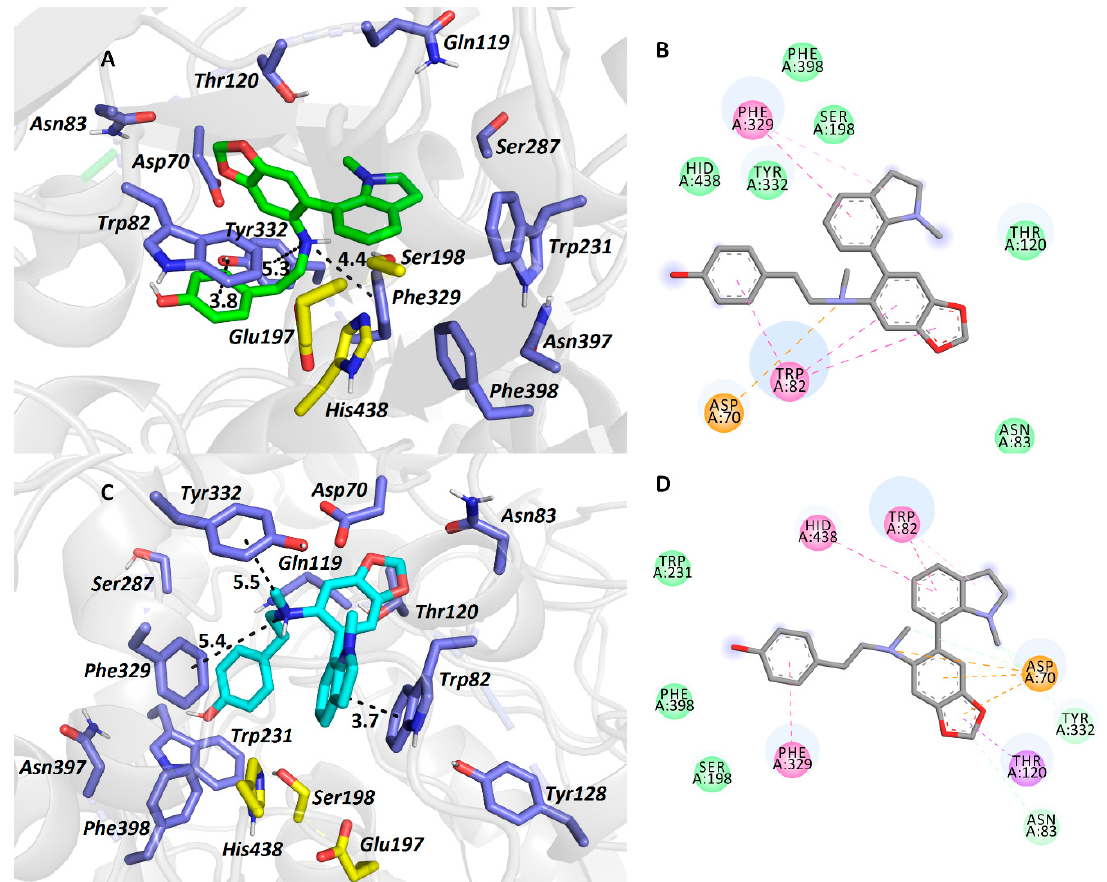
Figure 5. h BuChE active site in complex with ( R )- 14 (in green, A and B) and ( S )- 14 (in light-blue, C and D ) pseudo -enantiomers. All the amino acids exhibiting in the vicinity of the ligands up-to 6.0 Å are rendered. Hydrogen atoms of amino acids are omitted for clarity. Catalytic triad residues are shown in yellow and amino acid residues in blue ( A and C ). In 2D diagrams ( B and D ), crucial amino acid residues are displayed in different colours depending on the nature of the interaction (e.g., purple for π - π , orange for anion- π , dark green for van der Waals contact, light green for conventional hydrogen bond). Table 3. The best obtained calculated binding energies with Autodock Vina software for the carltonine derivatives under the in silico study within h BuChE enzyme.